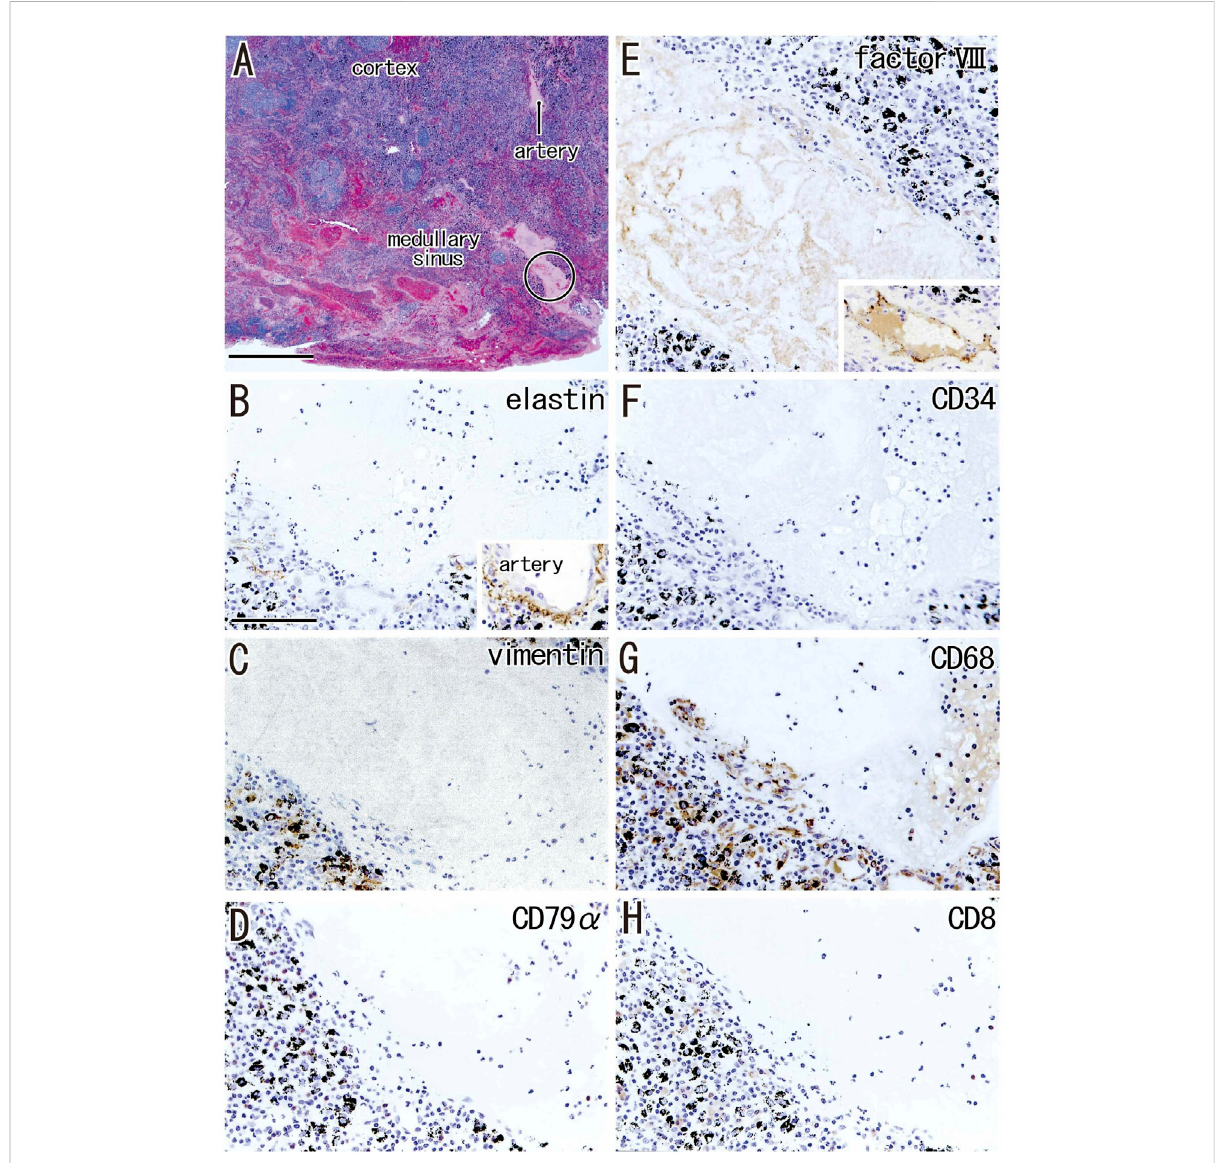
FIGURE 4 Early phase of the medullary sinus hyalinization. A subaortic node removed from a 70-years-old man (smoker). HE staining (A) and immunohistochemistry[ (B – H) ;nearsectionsof (A) ]. (B – H) arehighermagni fi cationviewsofasiteindicatedbyacircleinpanel (A) .TheDABreaction made the positive cells brown. The hyalinization, negative for immunostaining of elastin and CD34 (B,F) , contains no or few lymphocytes expressing CD79a or CD8 (D,H) . An insert at the lower angle of (B) exhibits the positive control of elastin immunostaining (an artery outside of the node). Vimentin-positive cells in the hyalinization (C) appear not to be CD68-positive (G) . Abundant macrophages carry carbon particles (anthracotic macrophages).A weak reactivity of factor VIII (E) is similar to a staining ofpostmortem hemolysis in athin vein[insert atthelower angle of (E) ]. (B – H) were prepared at the same magni fi cation [scale bars: 1 mm in (A) ; 0.1 mm in (B)